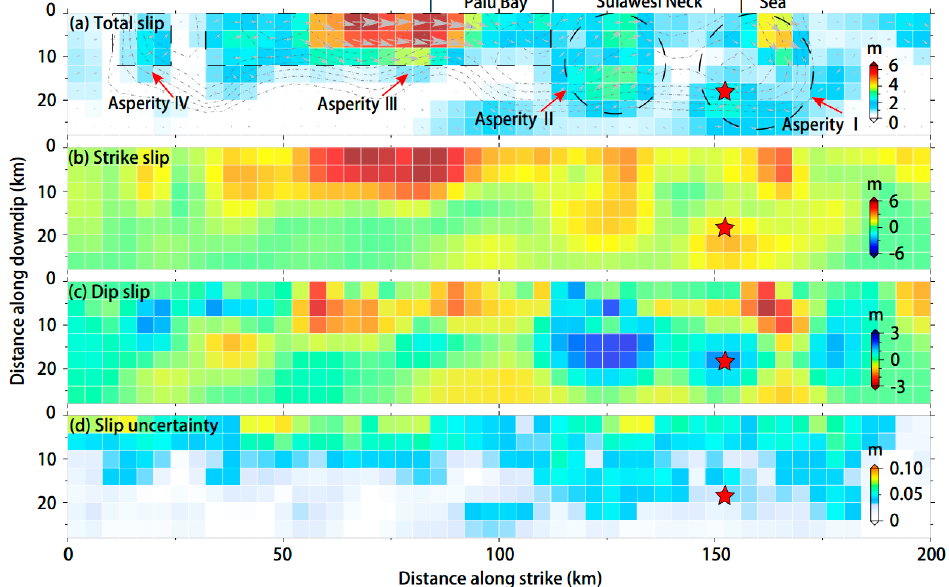
Figure 4. ( a ) Coseismic slip distribution from the joint inversion of InSAR and broadband regional seismograms. Gray arrows denote the slip directions of each fault patches. Gray dashed lines are the slip contours derived from Socquet et al. [7], with a slip magnitude greater than 1 m and a step of 0.5 m. The red star denotes the epicenter. ( b ) and ( c ) are the strike–slip and dip–slip components, respectively. ( d ) The uncertainty of the total slip